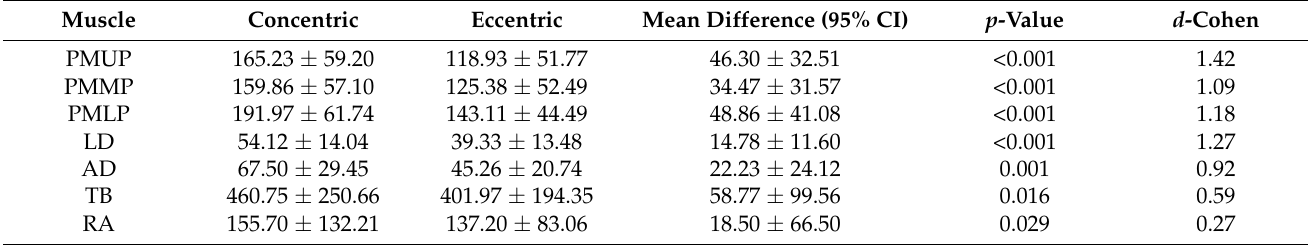
Table 2. Comparison of EMG activity (expressed in µV) during the concentric and eccentric phases in the pullover exercise. Mean ± standard deviation (SD).